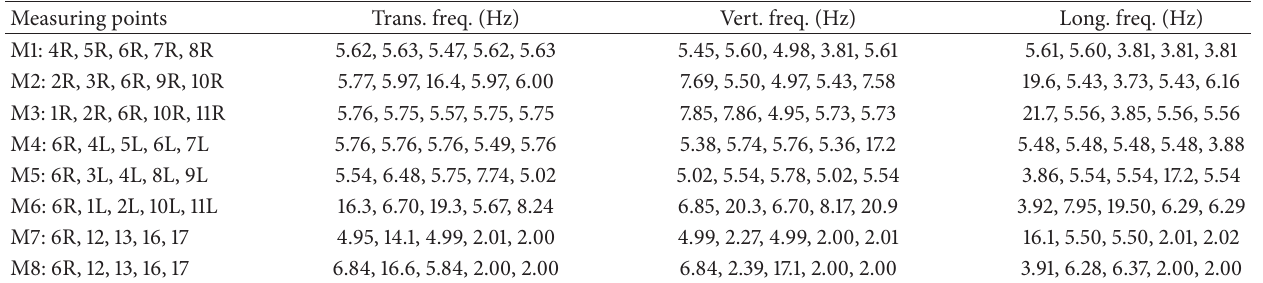
Table 2: Measured dominant frequency.